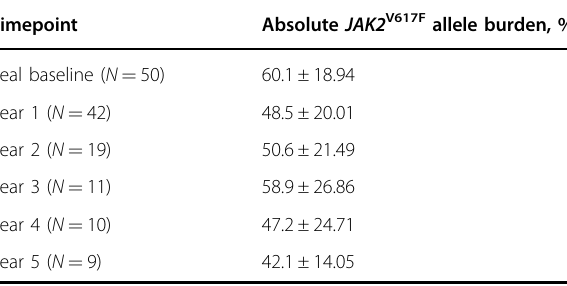
Table 3 JAK2 V617F allele burden (ITT population).